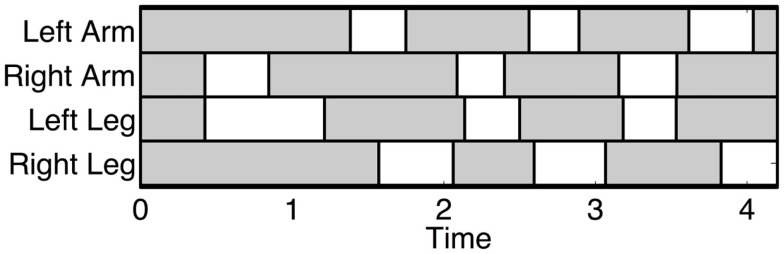
Typical footfall sequence (real data) of the infant standard crawling gait. The dashed boxes show the stance phases and the white ones the swing phases. In this case, the infant starts to crawl when the right arm swing first. The graph shows the long stance durations, the walking trot gait, and the fact that the arms swing slightly before the diagonal limbs.